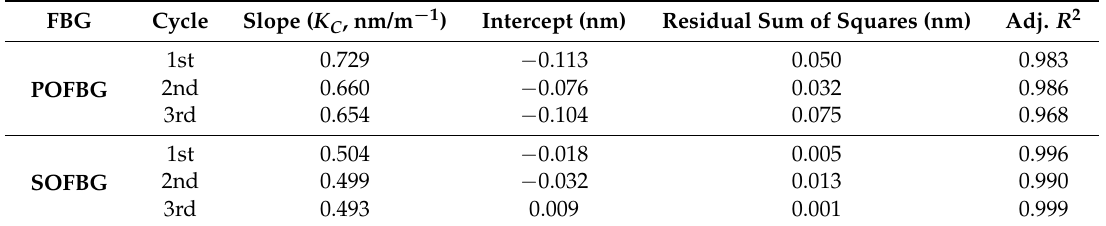
Figure 5. Bend response of POFBG ( a ) and SOFBG ( b ) on the upper surface of brass vs. the curvature in repeated upwards bending, where the beam length changed to 20 cm. Table 4. The linear fitting results of POFBG and SOFBG response to the repeated upwards bending.